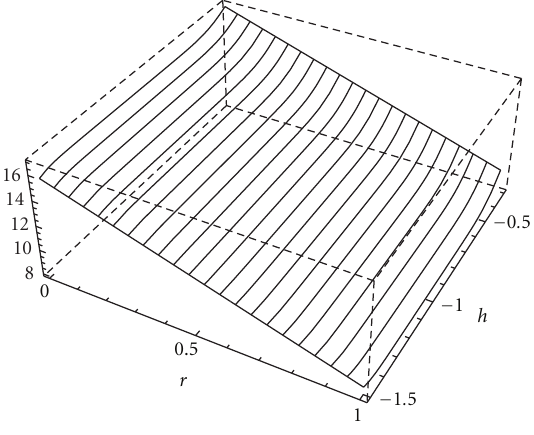
Figure 22: (cid:2) -mesh of ( ∂ 3 /∂t 3 ) G 10 (0, r ).